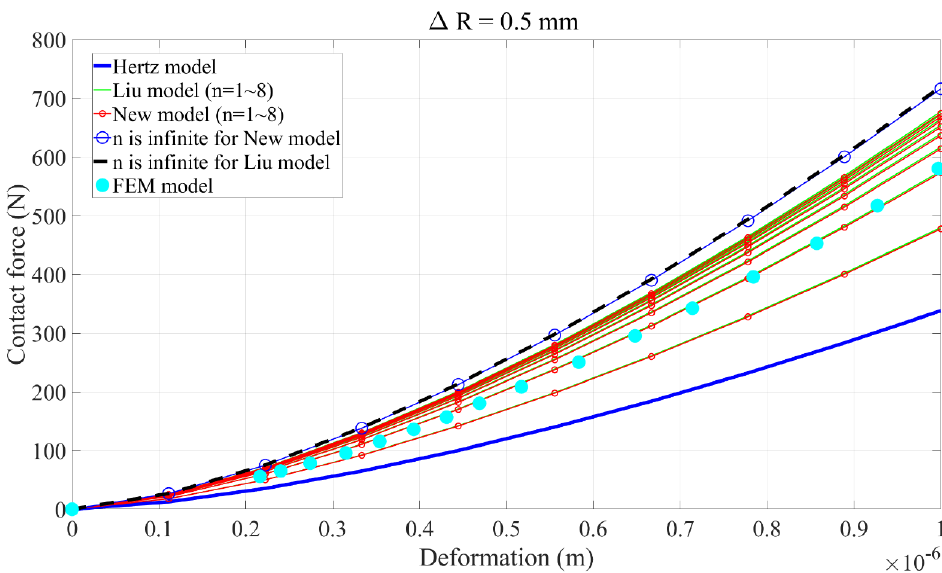
Figure 2. Finite element model of the spherical joint with clearance.